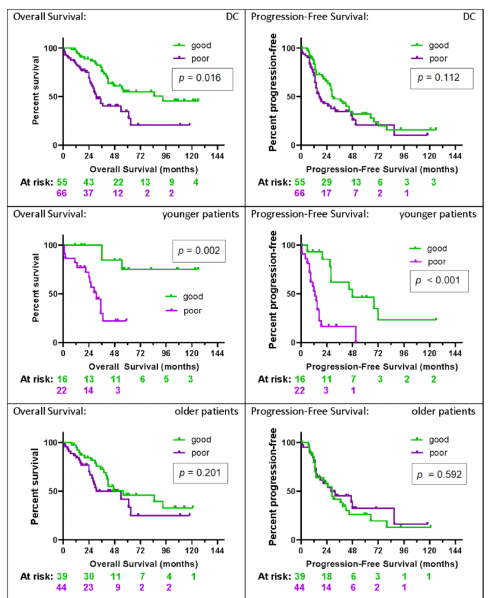
Figure 3. KM plots by test classification of overall and progression-free survival for all patients ( n = 121), younger patients ( n = 38), and older patients ( n = 83) with advanced-stage high-grade serous ovarian carcinoma in the development cohort. The number of patients at risk in the KM analysis at two-year intervals in each test classification group (green = good, and purple = poor) is shown below the x